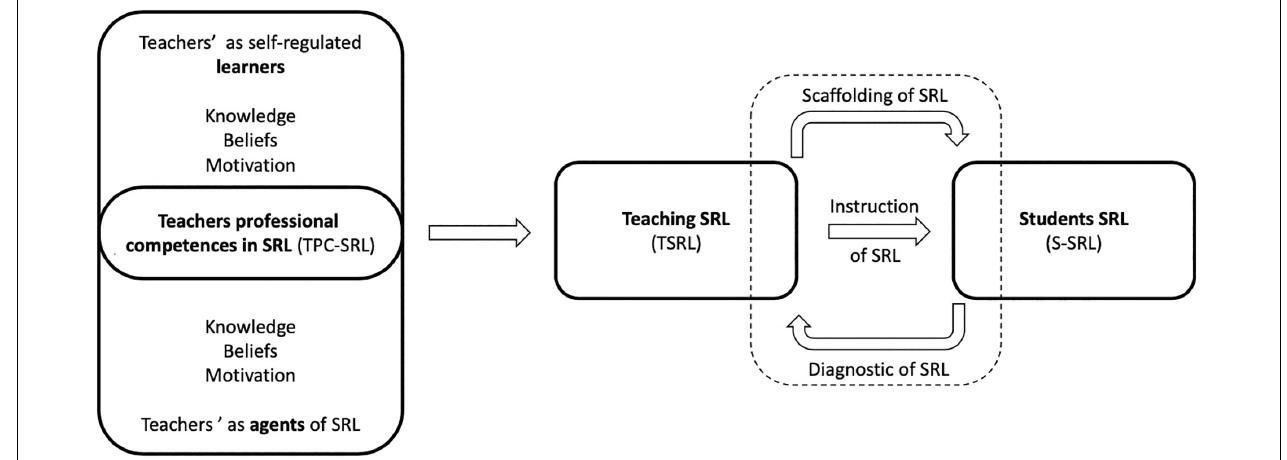
FIGURE 1 | Integrative framework of teachers’ professional competences and instructional practices in self-regulated